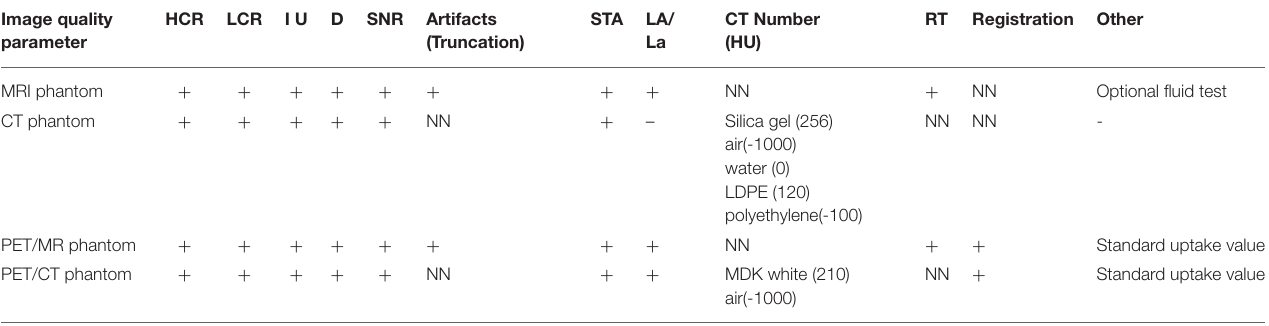
TABLE 3 | Summary of 3D-printed phantoms functionality. Image quality parameter